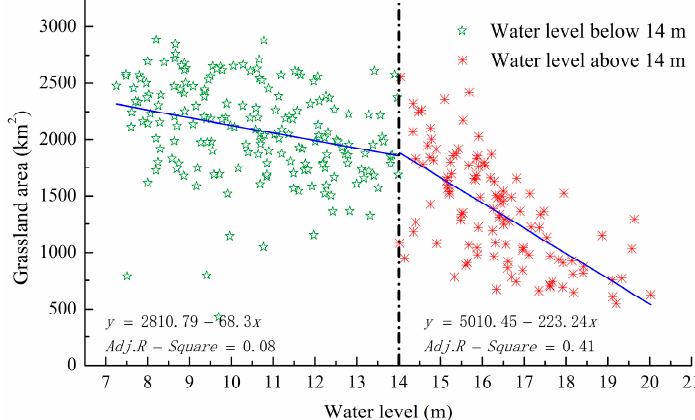
Figure 6. Relationships between grassland area in the Poyang Lake wetland and the fluctuations of Xingzi water level (separated at 14 m of water level).